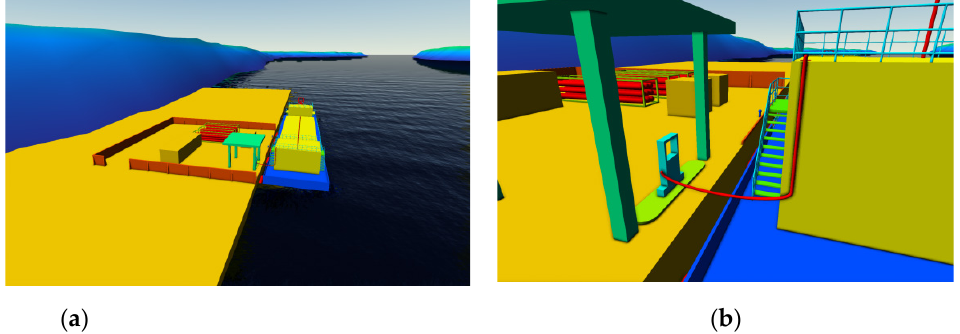
Figure 3. The overall and partial model of FLACS for shore-based bunkering operation for the hydrogen powered ship. ( a ) The Overall FLACS model; ( b ) The partial FLACS model.